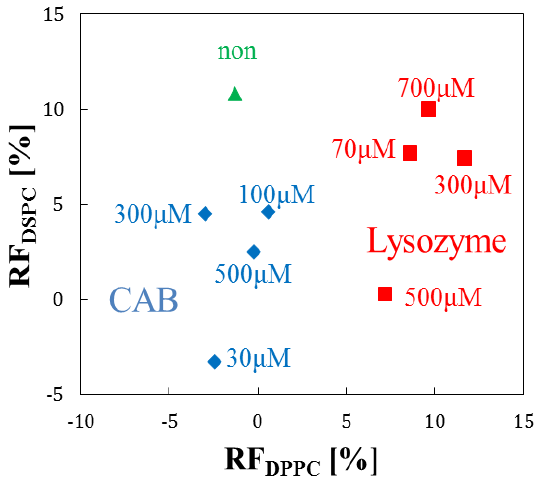
Figure 5. Scatter plot of averaged RF’s of DSPC and DPPC after 60 min from the initial addition of target proteins.